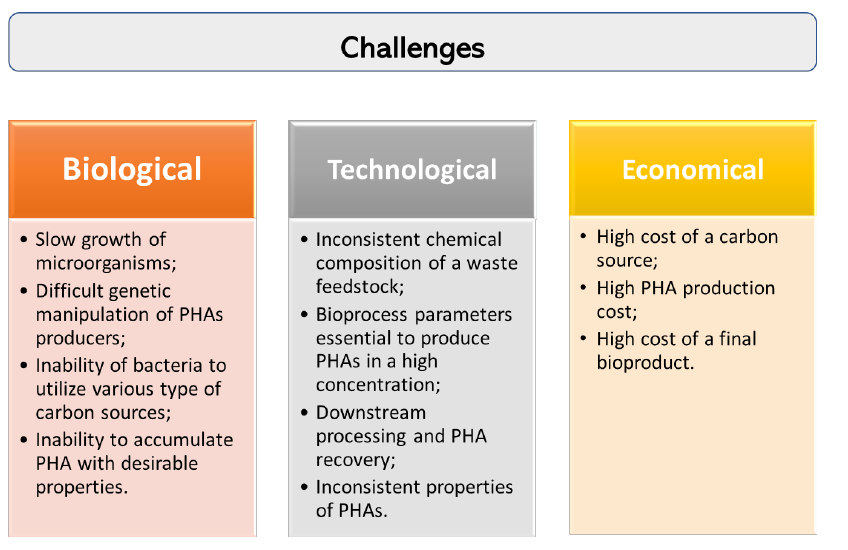
Figure 2. Challenges in PHA production from waste carbon